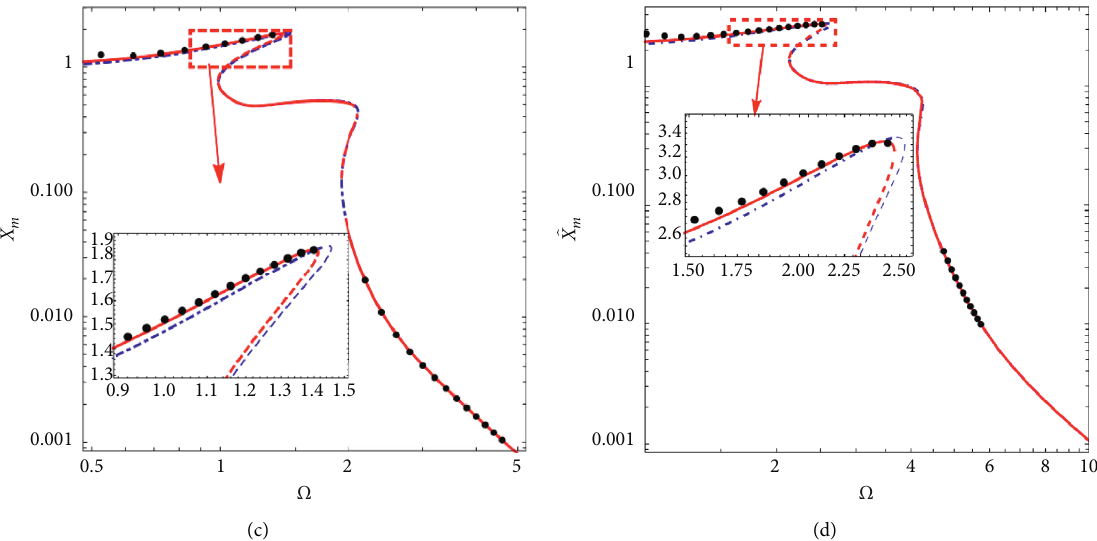
� 0 . 2, ζ � ζ � 0 . 01, ζ � ζ � 0 . 1, k k � 1, k k � k k � 7/6, 􏽢 l � 0 . 7, v 1 v 2 h 1 h 2 v 2 / v 1 h 1 / v 1 h 2 / v 1 s 2 when μ